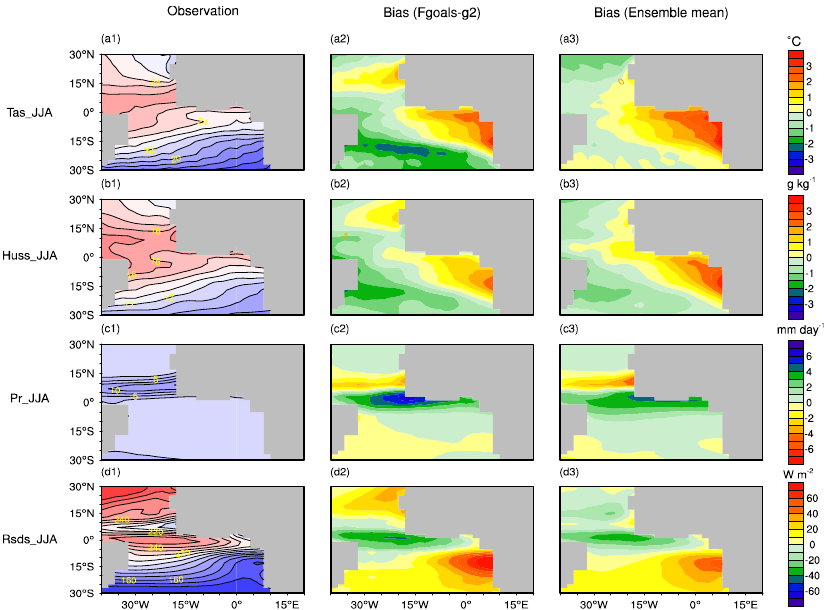
Figure 3. The surface air temperature (tas; ( a ); unit: °C), surface specific humidity (huss; ( b ); unit: g kg −1 ), precipitation (pr; ( c ); unit: mm day −1 ), and downward shortwave radiation (rsds; ( d ); unit: W m −2 ) during JJA of 1979–2005. The first column shows the mean value in the observational data, the second column shows the bias in FGOALS-g2 model, and the third column shows the bias of the ensemble mean of 21 CCMs in CMIP5.